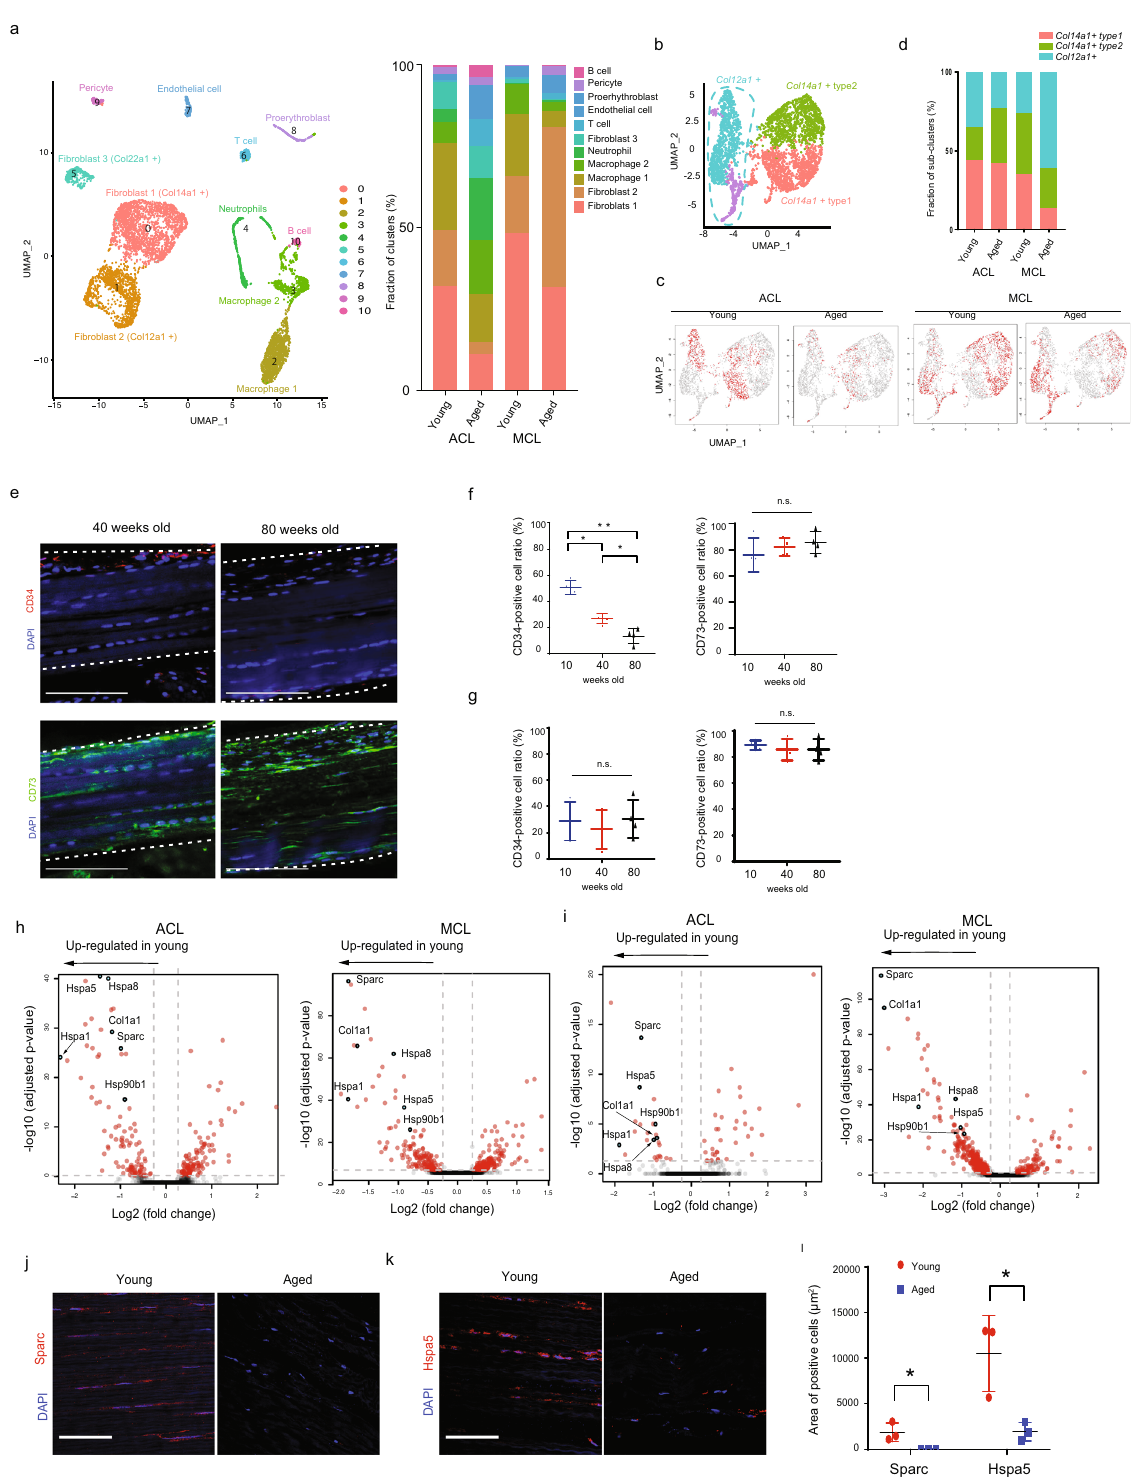
Fig. 5 Aging impacts gene expression in ligament fi broblasts. a Left: UMAP plots for articular ligament cells from 10- and 100-week-old mice. (10 mice, respectively) Right: Bar graphs indicate the fraction of each cluster. b , c UMAP plots for Col14a1 type-1 and type-2 and Col12a1 -positive cells from 10- and 100- week-old mice. MergedUMAPplot ( b ).UMAPplotsfrom ACL and MCL,and 10- and100-week-old mice ligaments ( c ). d bar graphsindicatetheratio between Col14a1 type-1 and type-2 and Col12a1 -positive cells. e Immunostaining of Cd34 and Cd73 in MCLs from 40- and 80-week-old mice. Scale bar: 100 μ m. f, g graphs with dot plots indicate the percentage of Cd34- and Cd73-positive cells in the MCL ( f ) and ACL ( g ). p values were calculated using one-way ANOVA; * p < 0.05. ** p <0.001. n = 4. h , i Comparison of DEGs between young and aged fi broblasts in Col14a1- and Col12a1-positive cells. Volcano plots for Col14a1 - ( h ) and Col12a1 -positive cells ( i ). j , k Immunostaining of Sparc ( j ) and Hspa5 ( k ) in human young (25 years old) and aged (76 years old) ACL ligaments. Scale bar: 100 μ m. l Expression area of Sparc- and Hspa5-positive cells. p-values were calculated using the Wilcoxon signed-rank test, * p < 0.05. n =